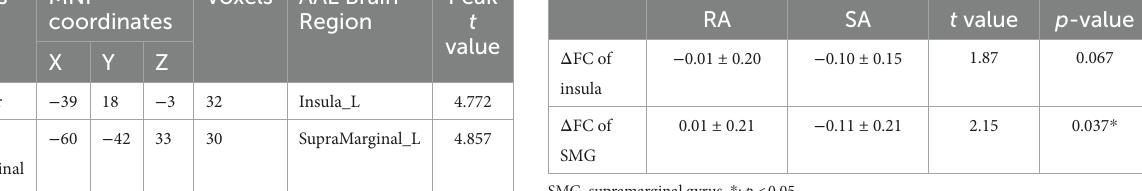
TABLE 5 Brain regions showing stronger FC in RA compared with SA. Clusters